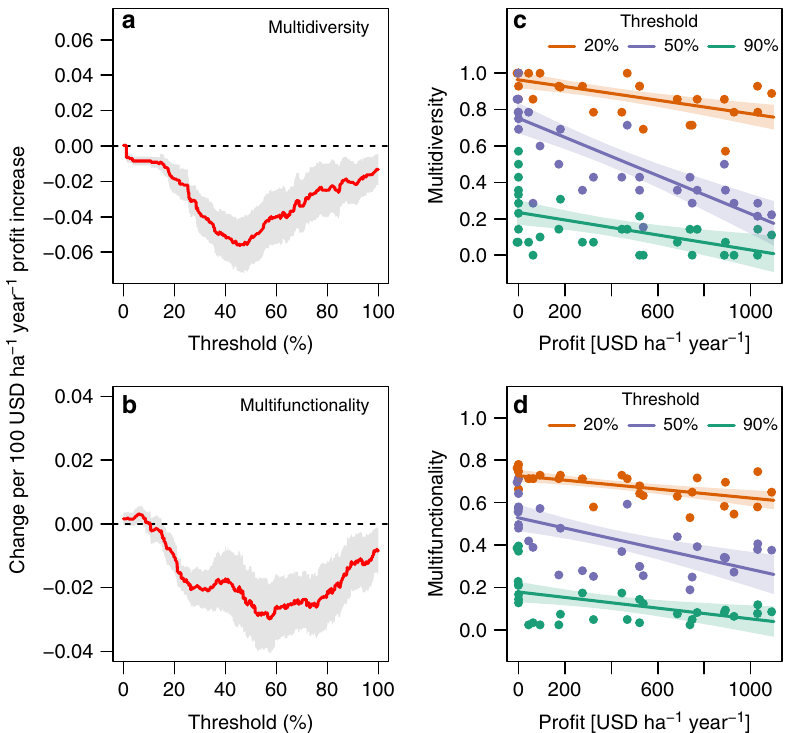
Fig. 4 Multidiversity-pro fi t and multifunctionality-pro fi t relationships are generally negative, regardless of thresholds used to de fi ne multidiversity or multifunctionality. Changes in a multidiversity (whole-system biodiversity of all species in 14 taxonomic groups) and b multifunctionality (whole-system ecosystem functioning based on 36 indicators of 10 functions) per pro fi t increase of 100 USD ha − 1 year − 1 in smallholder farms. All indices range between 0 and 1, whereby 1 is the highest-possible level of multidiversity or multifunctionality. Note that relationships are usually negative, regardless of the threshold that taxonomic groups or ecosystem functions need to reach to contribute to multidiversity or multifunctionality (red lines are predicted slopes; shaded areas indicate 95% con fi dence bands). In addition, shown are examples of c multidiversity-pro fi t and d multifunctionality-pro fi t relationships for thresholds of 20%, 50%, and 90%, respectively (points are raw data; fi tted lines and shaded areas are predictions from linear models and 95% con fi dence bands, respectively; P < 0.05 in all cases, tested with simple linear regression). Source data are provided as a Source Data fi